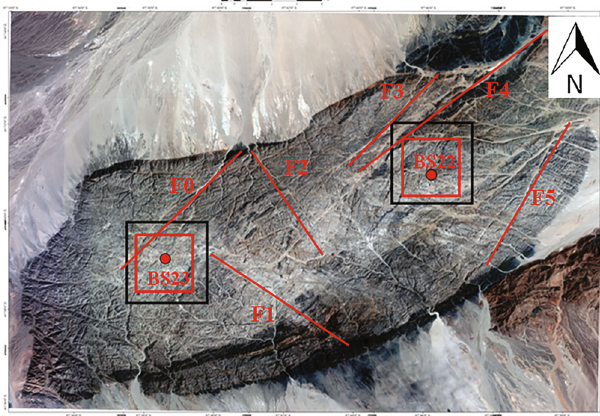
Figure 2: Joint investigating area and fault distribution for Suan Jingzi